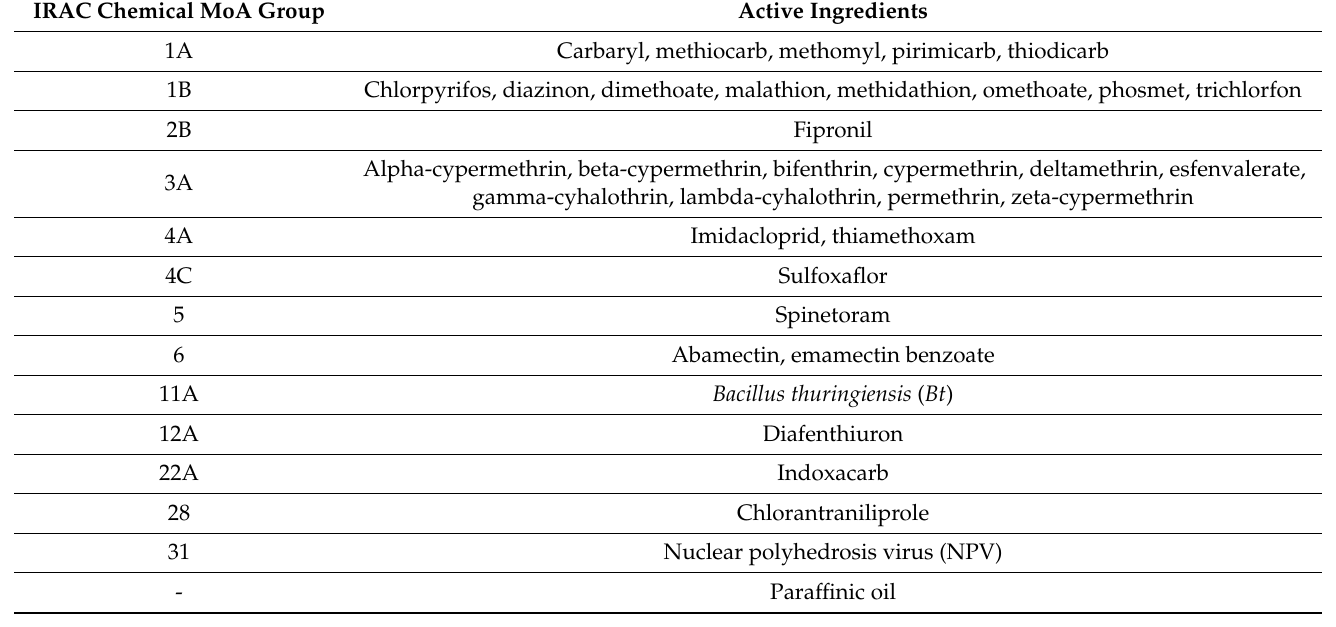
Table 1. Insecticide and miticide active ingredients currently registered for use within Australian grains (excluding amorphous silica) and their corresponding Insecticide Resistance Action Committee (IRAC) chemical Mode of Action (MoA) [25]